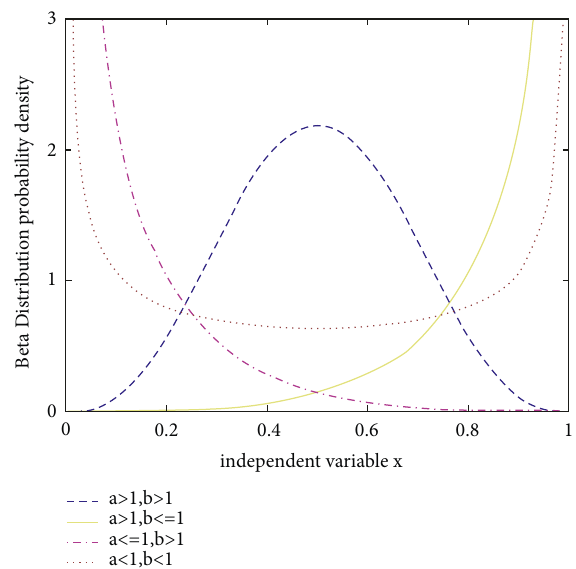
Figure 1: Probability density functional curve of beta